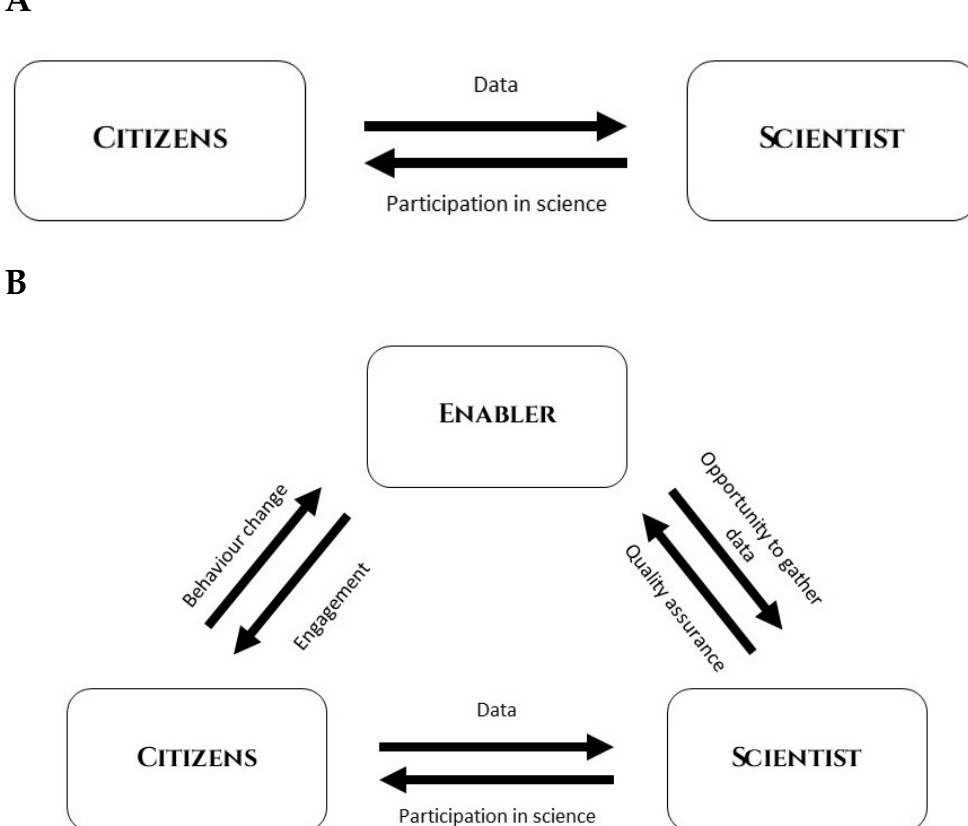
Figure 1. Two contrasting representations of Citizen Science: ( A ) The traditional two-party model involving only citizens and scientist. ( B ) An idealised form of the tripartite model of citizen science. Boxes indicate different roles in the project. Arrows indicate what each role is providing to (or receiving from) another, e.g., in ( B ), the enabler provides the citizen with an opportunity to engage whilst the citizen adapts their behaviour in such a way that aligns with the one of the enabler’s goals.